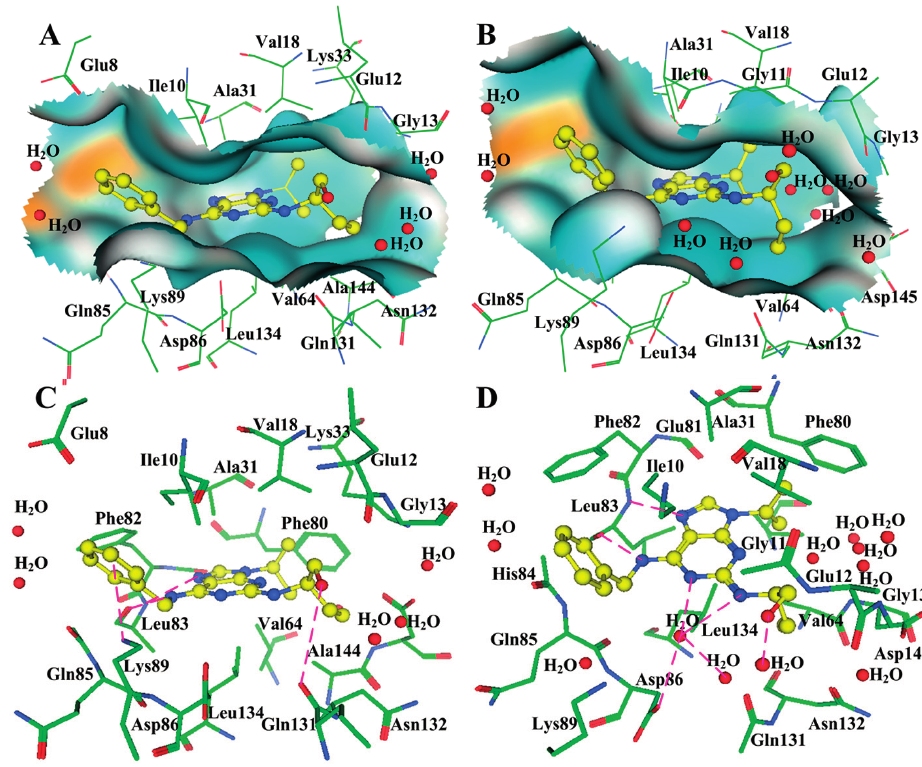
Figure 13. The binding pockets and interaction mechanisms of roscovitine in free and phosphorylated CDK2 dimers. ( A , C ) are for the monomeric CDK2 (coordinates 2A4L); ( B , D ) are for the phosphorylated CDK2 state (3DDQ),